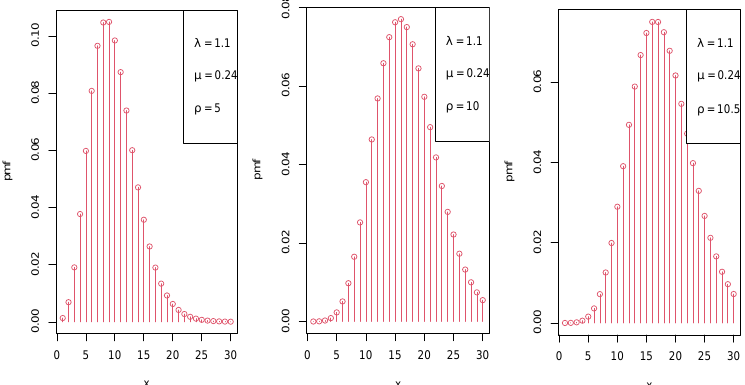
Figure 3. Various shapes of the PMF of the LIPD when ρ increases.